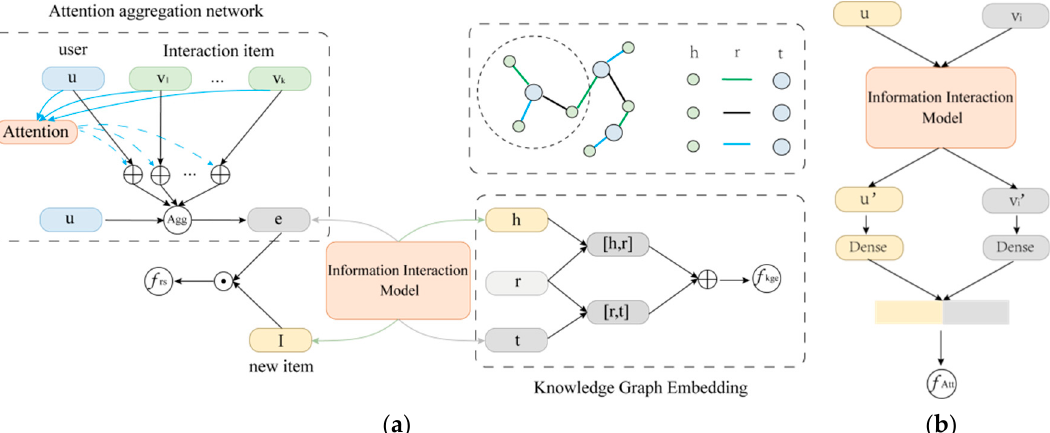
Figure 2. ( a ) The framework of KANR. The left-hand side shows the attention aggregation network. The user and interaction item vector is aggregated into e . The right-hand side shows the knowledge graph embedding model. After feature fusion through the Information Interaction model, e and i are regarded as t and h to predict the semantic relationship. At the same time, e and i are connected to calculate the recommendation confidence. ( b ) The attention model in KANR. After feature fusion through the Information Interaction model, the user and an interacted item vector is connected to calculate the attention.